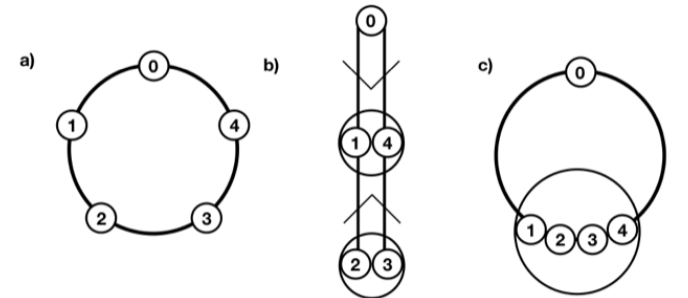
Figure 5: The extended Dynkin diagrams for breaking patterns of SU ( 5 ) : a) SU ( 5 ) , b) Sp ( 4 ) , and c) SU ( 2 ) . The directed double lines for Sp ( 4 ) indicate that the roots a are separated by 135 ◦ , and the arrows point from a long root to a short root.